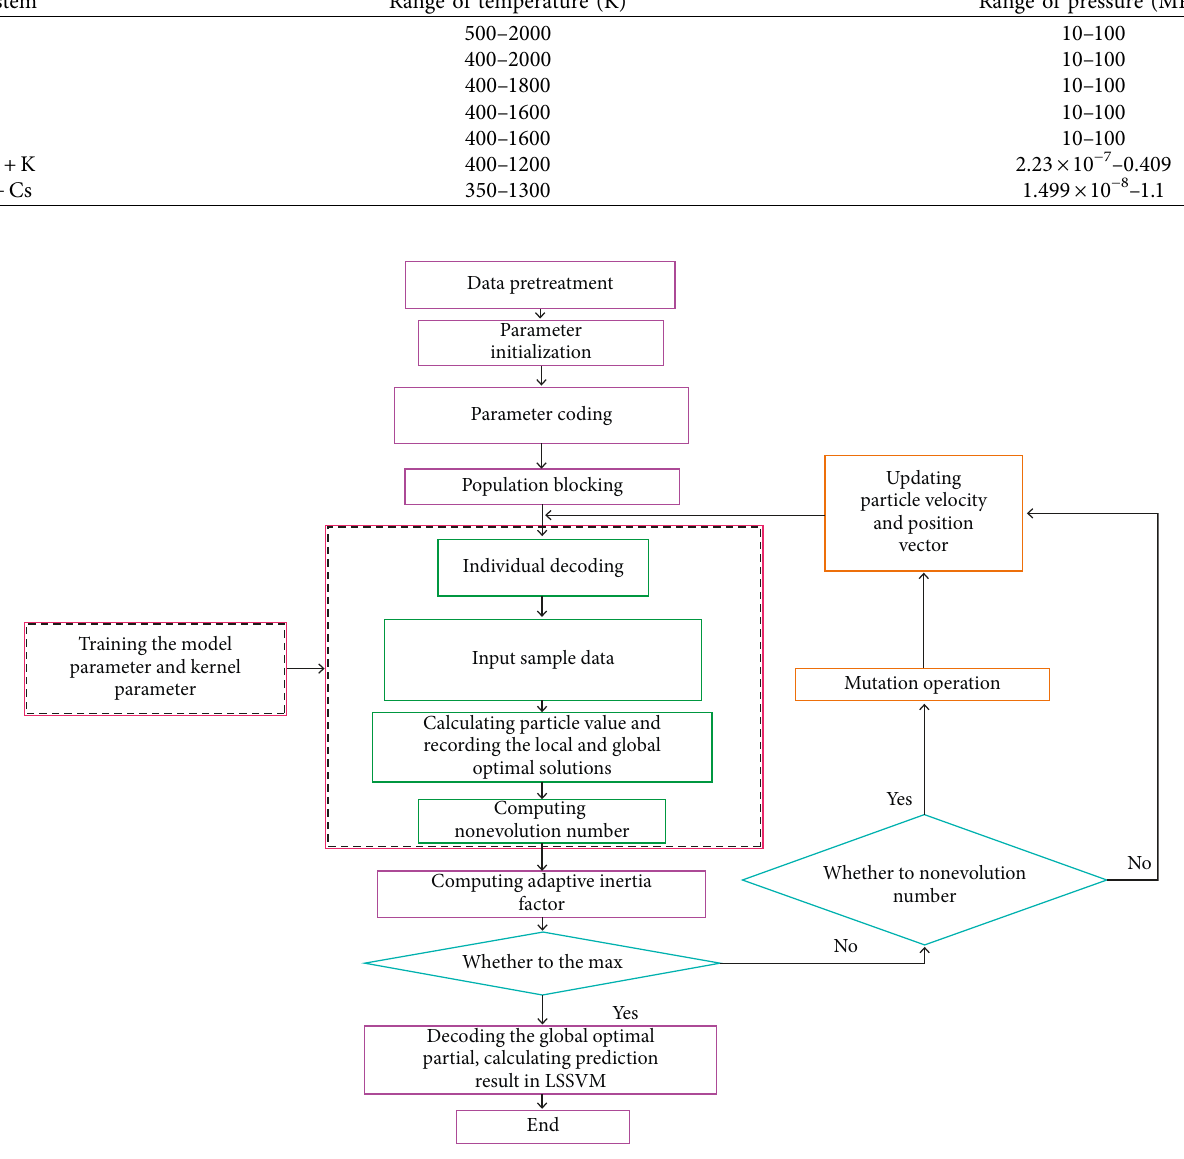
Figure 1: Training of LSSVM